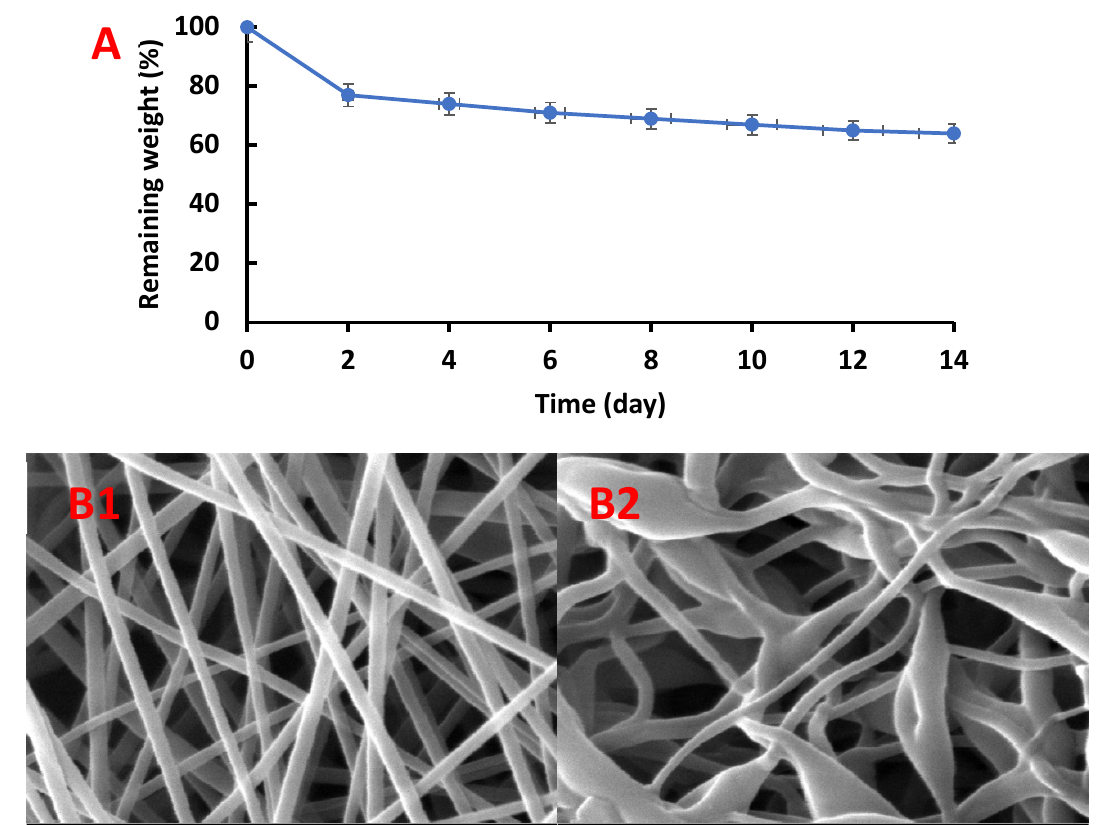
Figure 8. ( A ) Degradability of SF-CS-Ag-CUR (CS 9% w / v ) and SEM images of of SF-CS-Ag-CUR (CS 9% w / v ) nanofibers before ( B1 ) and after 14 days of incubation ( B2 ) in PBS solution.